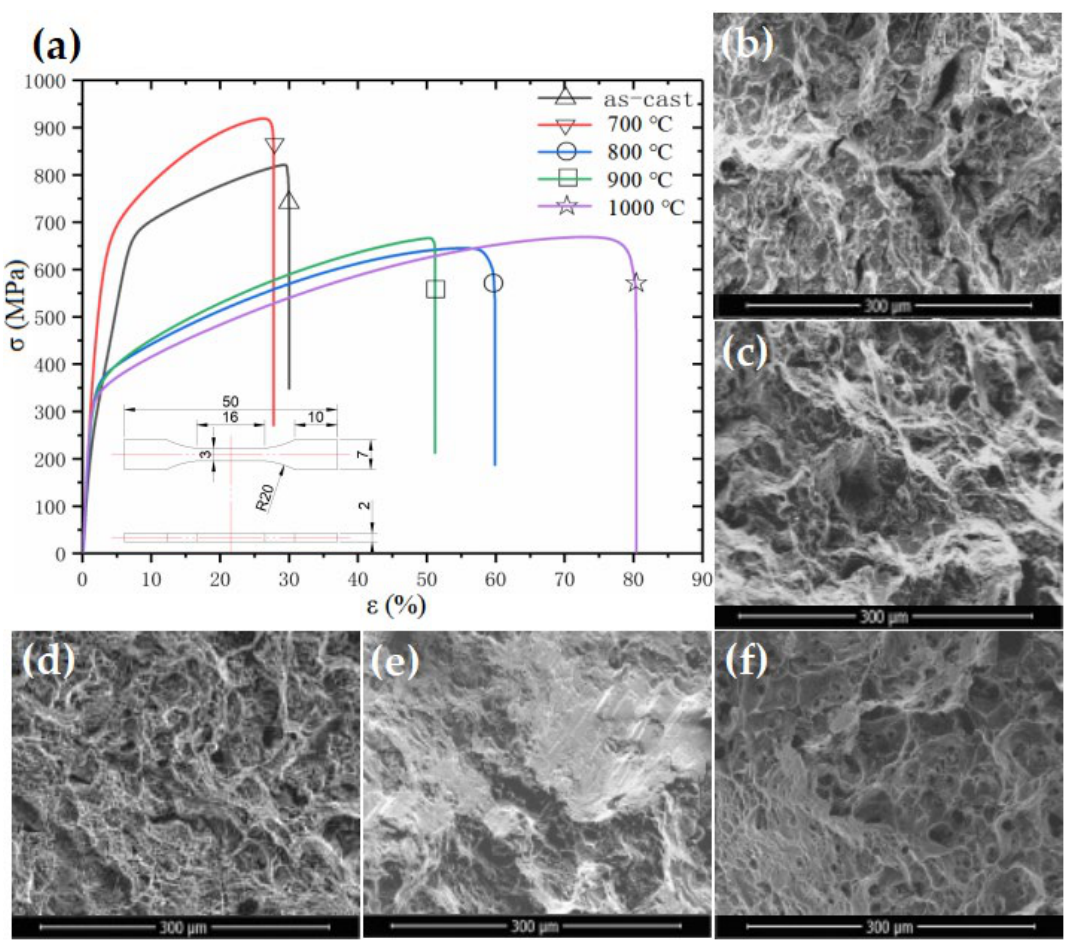
Figure 6. Stress–strain curves and microstructure morphology of (FeNi)67Cr15Mn10Al5Ti3 HEA at different annealing temperatures: ( a ) stress–strain curves; ( b ) as-cast; ( c ) 700 °C; ( d ) 800 °C; ( e ) 900 °C; ( f ) 1000 °C. Table 2. Tensile properties of (FeNi)67Cr15Mn10Al5Ti3 HEA.